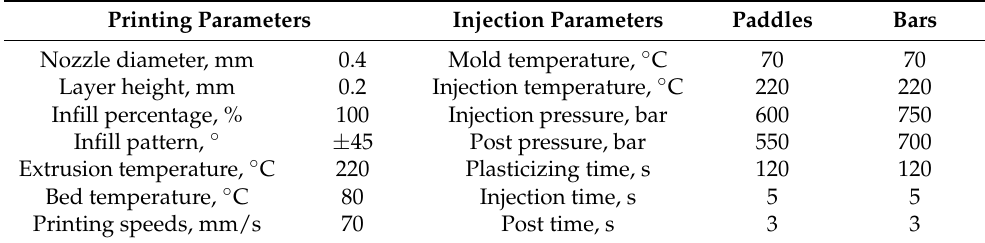
Table 2. Selected printing and injection parameters.